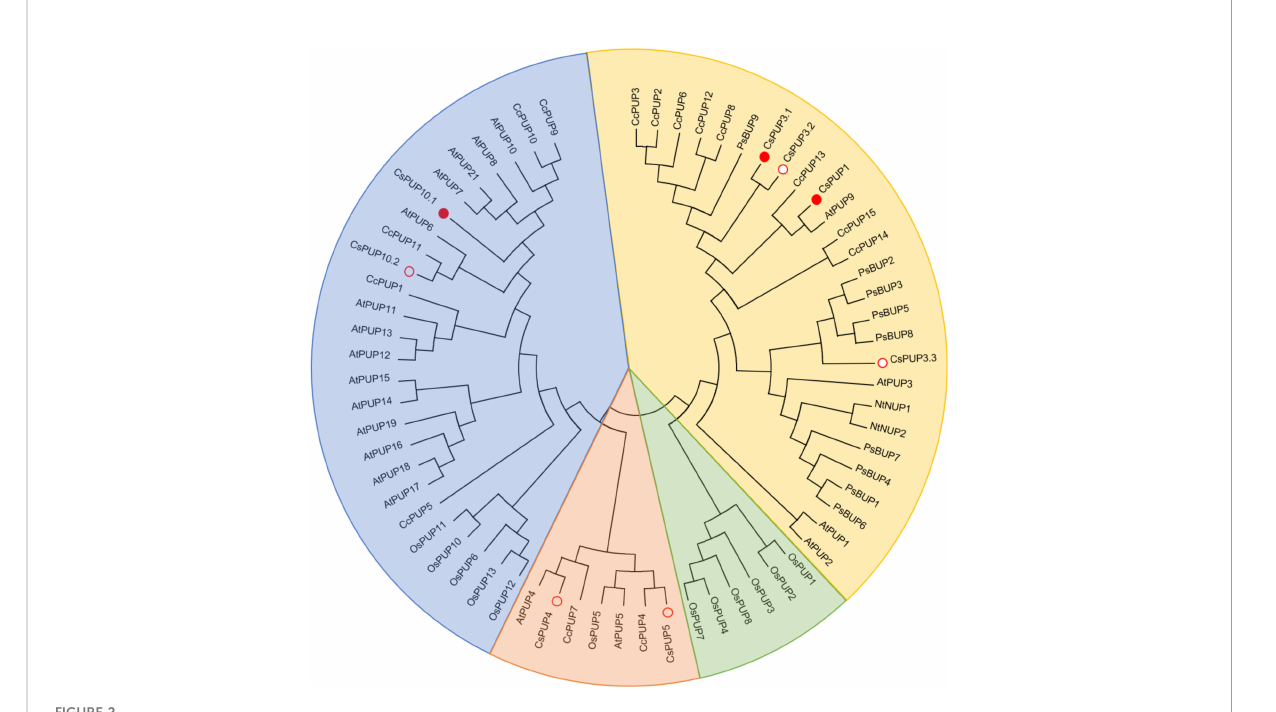
FIGURE 2 Phylogenetic tree analysis of PUP family